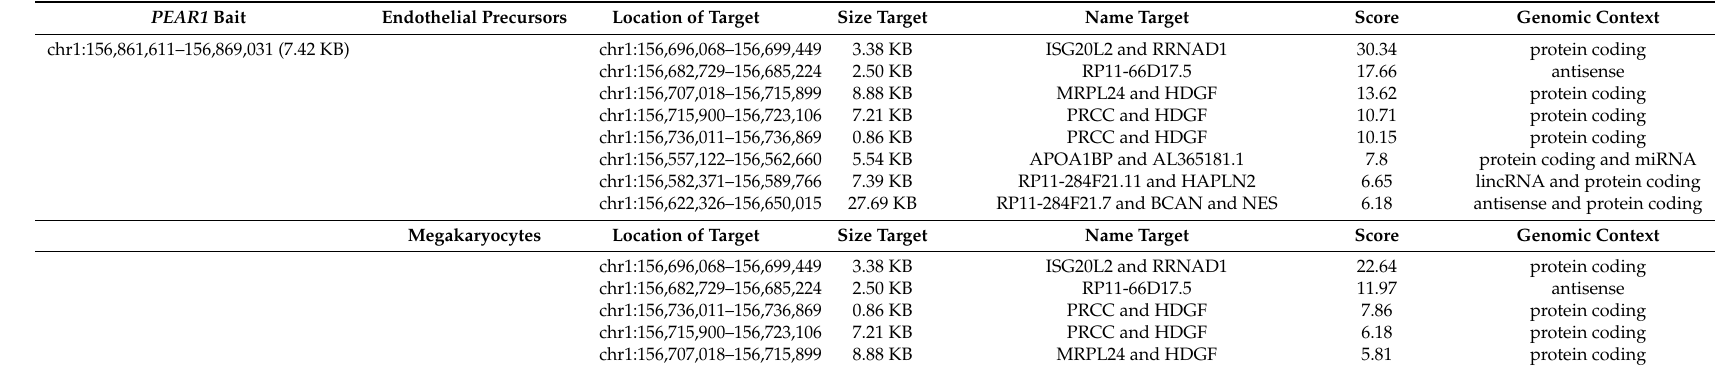
Table 1. PEAR1 interacting genes.